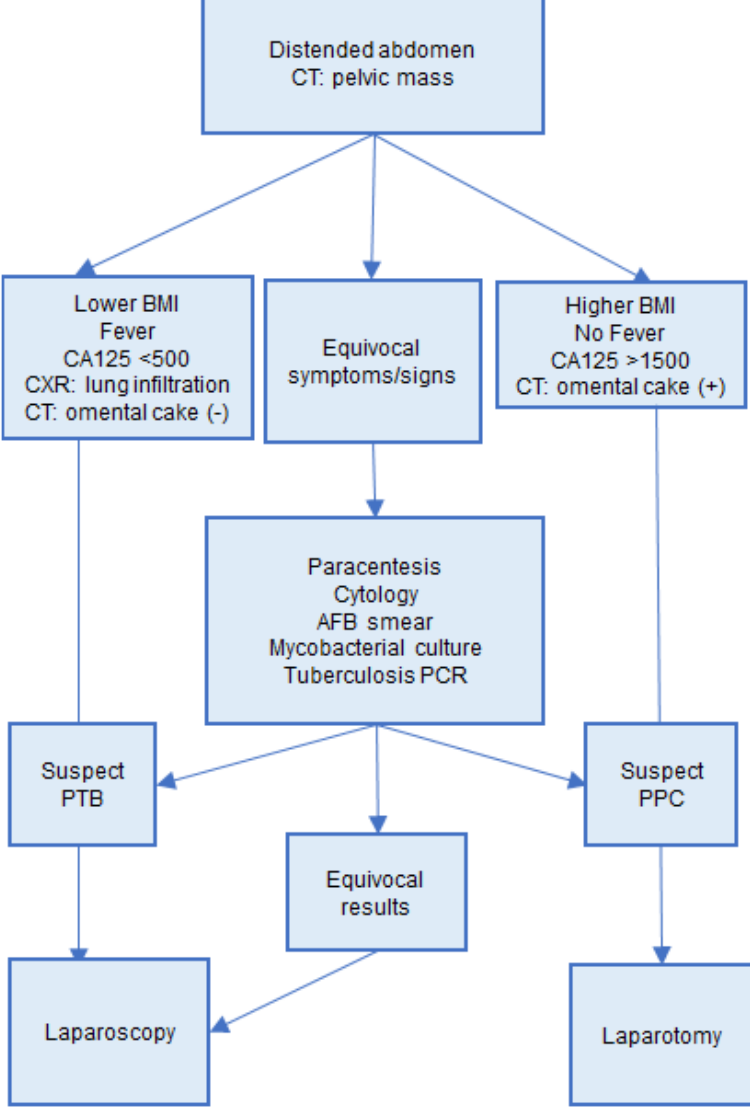
Figure 2. Algorithm for differential diagnosis of PTB and PPC. PTB, peritoneal tuberculosis; PPC, primary peritoneal cancer.